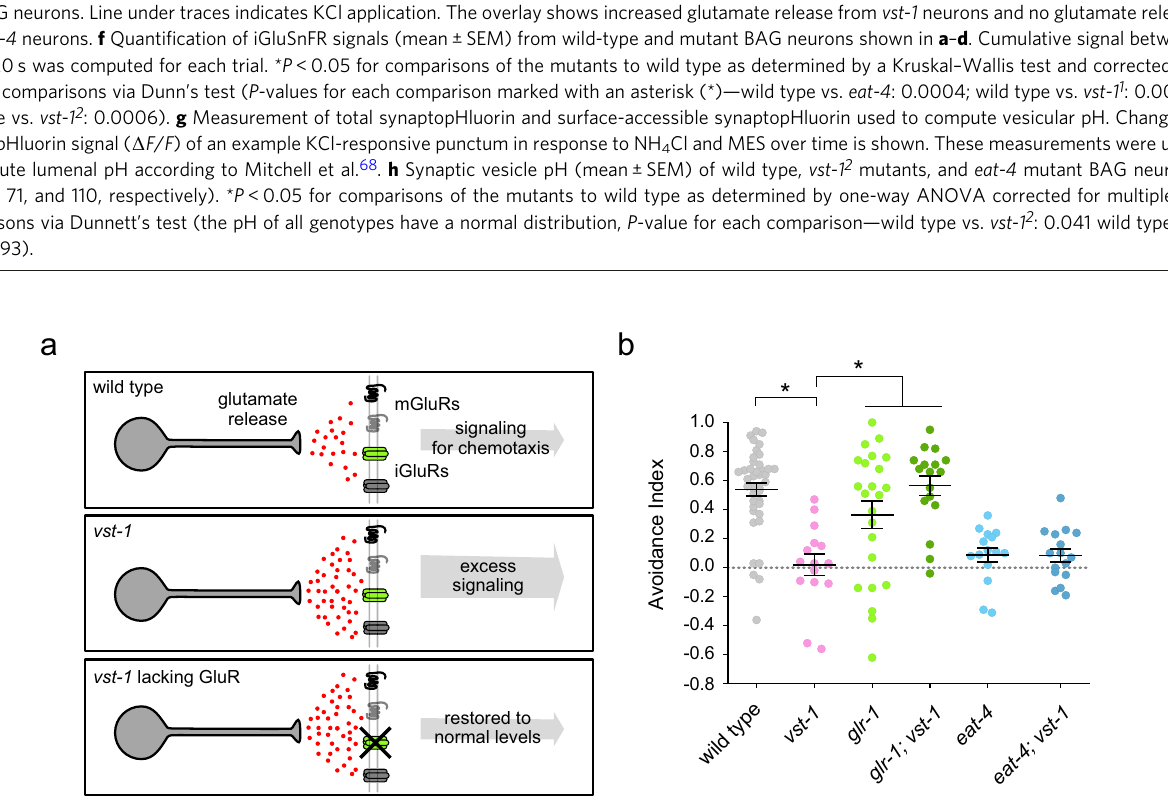
Fig. 4 The CO 2 chemotaxis defect of vst-1 mutants requires an AMPA-type glutamate receptor. a Schematic of a test for the hypothesis that excess glutamate signaling causes chemotaxis defects by over-activating glutamate receptors. mGluRs: metabotrobic glutamate receptors; iGluRs: ionotropic glutamate receptors. b Avoidance indices (mean ± SEM) of vst-1(gk308047) , glr-1(n2461) , and eat-4(ky5) mutants during chemotaxis from 10% CO 2 ( n = 40, 15, 23, 17, 15, and 16 for wild type, vst-1 , glr-1 , glr-1;vst-1 , eat-4 , and eat-4;vst-1 , respectively). * P < 0.05 from comparisons of the indicated strains to vst-1 mutants as determined by a Kruskal – Wallis test corrected for multiple comparisons via Dunn ’ s test ( P -values for each comparison marked with an asterisk (*) — vst-1 2 vs. wild type: 3.5 × 10 − 5 ; vst-1 2 vs. glr-1 : 0.019; vst-1 2 vs. glr-1;vst-1 2 : 2.0 × 10 − 4